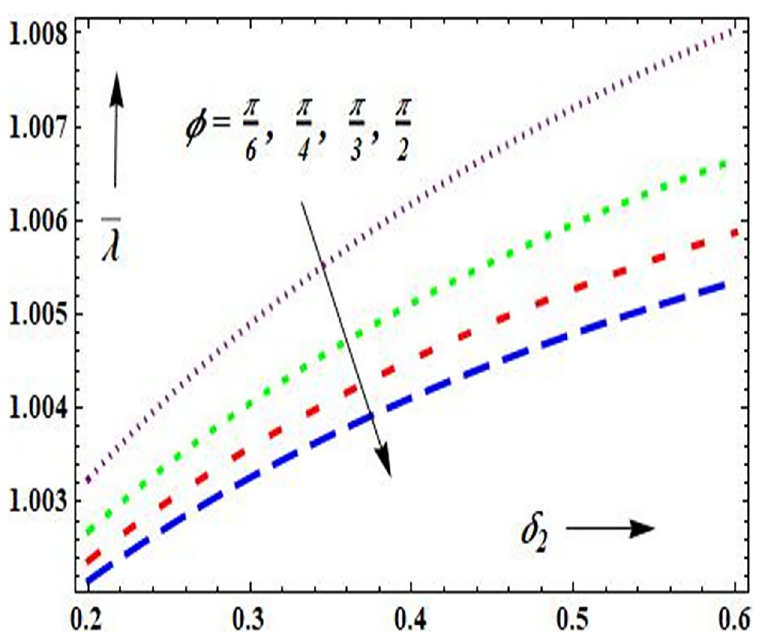
Fig 7. Plot of � λ on ϕ & δ 2 with r = 0.2, d 1 = 0.2, F = 0.3, d 2 = 0.6, L 2 = L 1 = 0.2, M = 2.0, Q = 0.1.